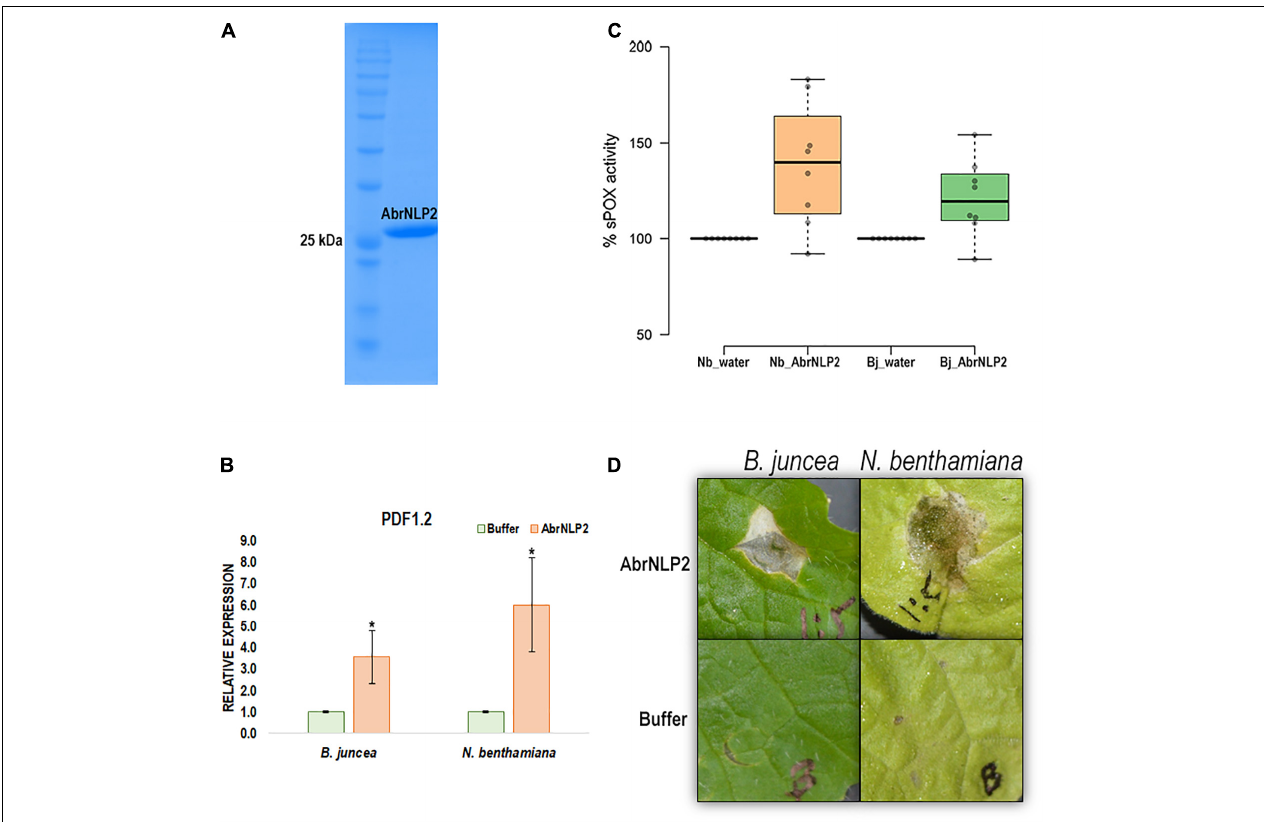
FIGURE 6 | AbrNLP2 induces necrotic cell death and PTI responses. (A) Ni-NTA based purification of AbrNLP2. (B) Relative expression of PDF1.2 in AbrNLP2 and buffer treated leaf disks of N. benthamiana and B. juncea . TIPS41 was used as an endogenous control. * P < 0.05 by Mann–Whitney U -test. (C) %sPOX activity of N. benthamiana and B. juncea in response to purified AbrNLP2 as compared to water (control). (D) Cell death induced by purified AbrNLP2 in N. benthamiana and B. juncea